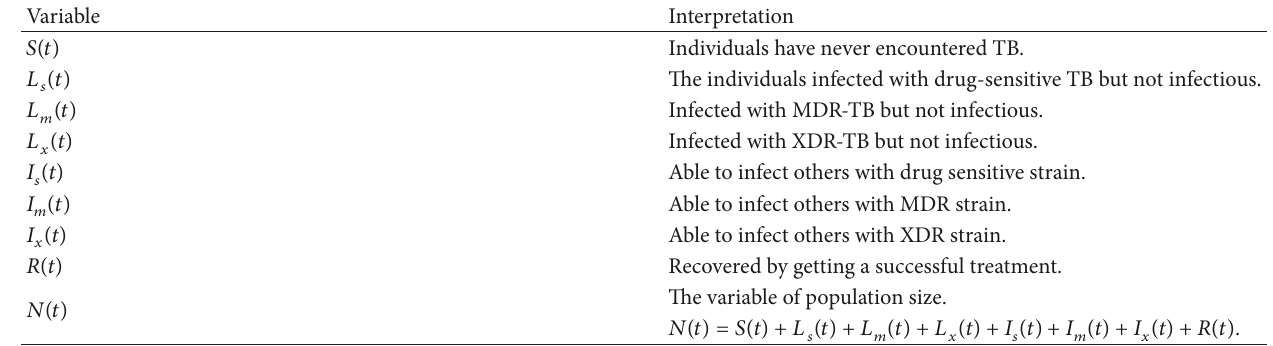
Table 1: Interpretation of the variable states of system (1).